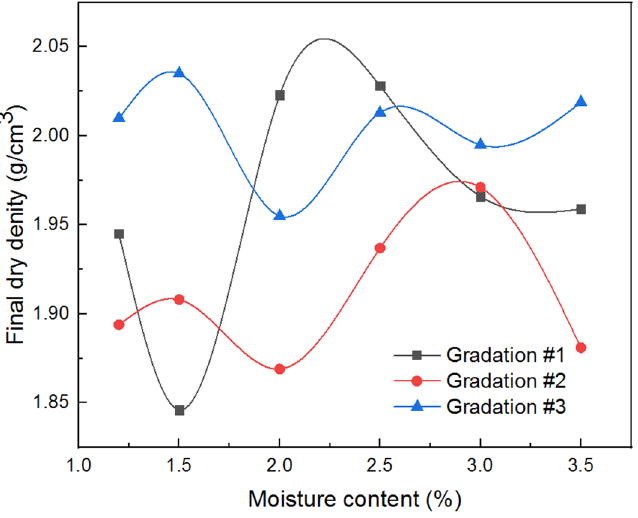
Figure 9. Moisture–density curves obtained from gyratory compaction tests for three different gra- dations.